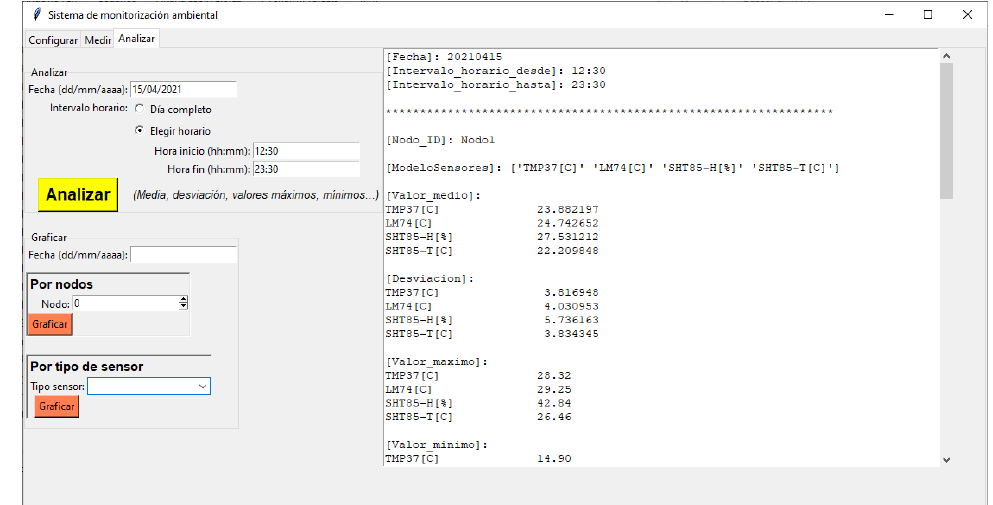
Figure 7. HMI application: Basic analysis of historical data.